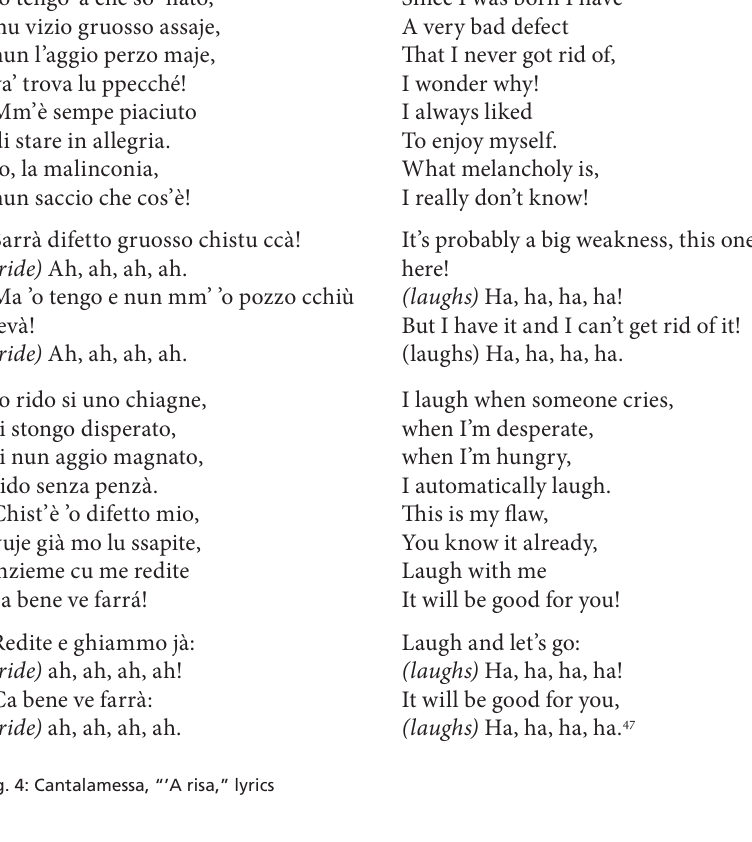
45 See note 6. 46 The lyrics are printed in the sheet music for “’A risa.” The song originally comprises three stanzas, but the film uses only two of them in a free arrangement. 47 The English translation is